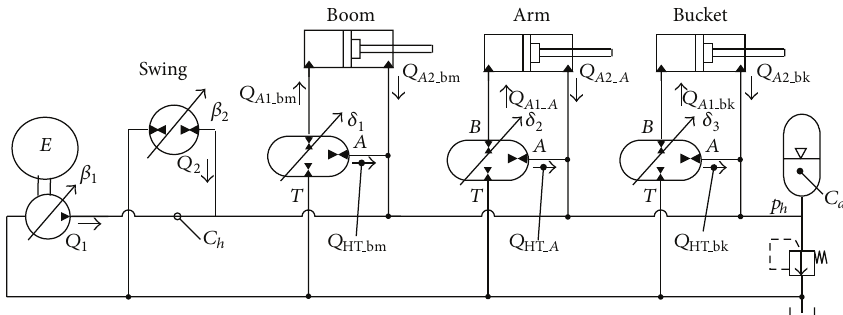
Figure 5: Schematic of the